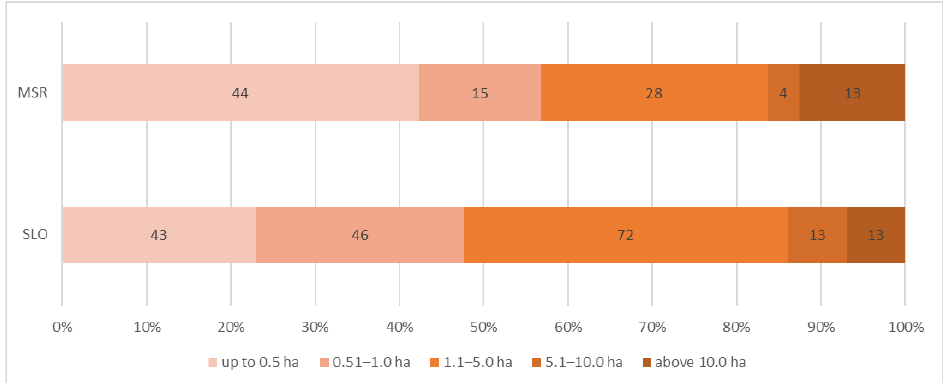
Figure 8. New forms of land use according to brownfield size. Based on [24 – 27]. Prepared by the authors.